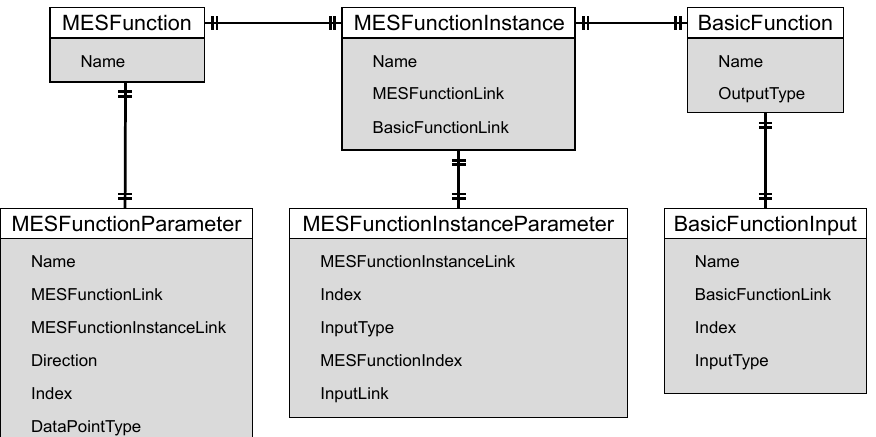
Figure 5. ERD of tables for MES function model.